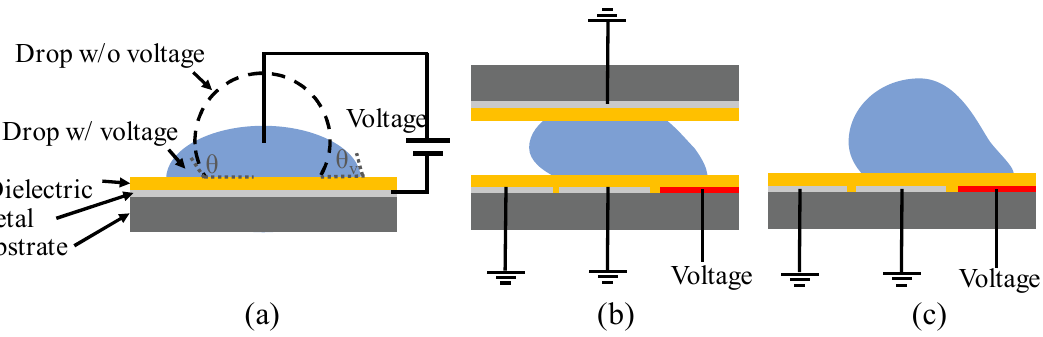
Figure 9. Electrowetting-on-dielectric (EWOD) setup: ( a ) Typical EWOD setup to measure contact Figure 9. E lectrowetting‐on‐dielectric (EWOD) setup: ( a ) Typical EWOD setup to measure contact angle change by external voltage. ( b ) Parallel-plate EWOD design to transport droplet. ( c ) Open angle change by external voltage. ( b ) Parallel‐plate EWOD design to transport droplet. ( c ) Open coplanar EWOD design. The energized electrodes are marked as red color in ( b , c coplanar EWOD design. The energized electrodes are marked as red color in ( b ) and ( c ).